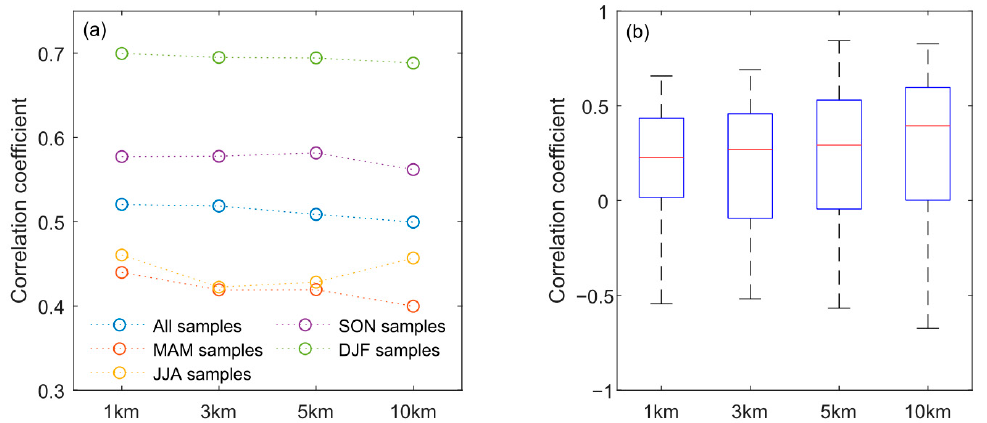
Figure 2. ( a ) The correlation coefficients between PM 2.5 concentration and AOD at the resolutions of 1, 3, 5 and 10 km over the Yangtze River Delta for different seasons. Based on the spatial AOD–PM 2.5 correlation for each day in summer, the box-and-whisker in panel ( b ) shows 10th, 25th, 50th, 75th and 90th percentile values of the correlation for different resolutions. Note that the spatial AOD–PM 2.5 correlation for a given day is excluded in panel ( b ) if the number of AOD–PM 2.5 pairs is less than 10.